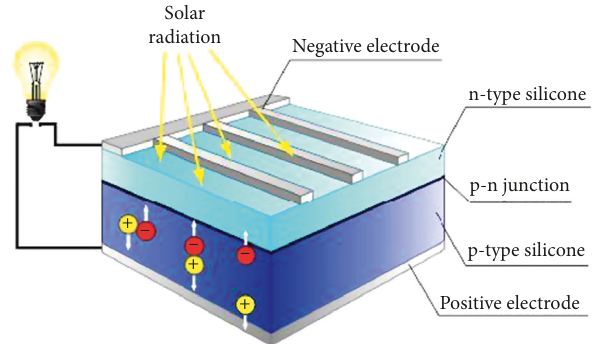
Figure 7: The construction of a photovoltaic